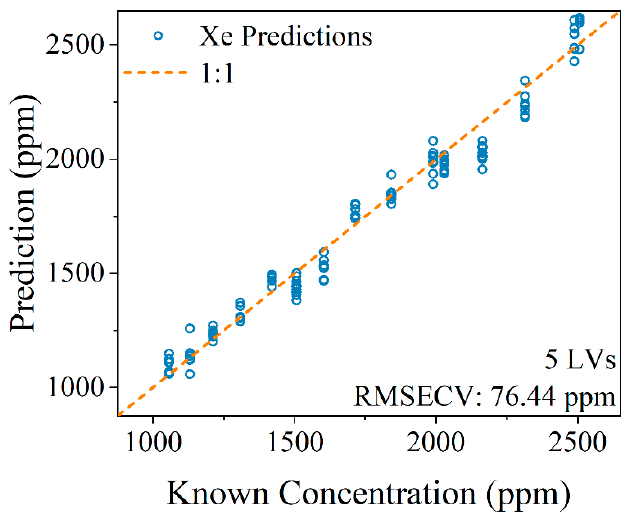
Figure 6. Parity plot comparing known Xe concentrations to those predicted by a multivariate partial least squares model. If a point falls on the dashed 1:1 line it represents a perfect prediction.